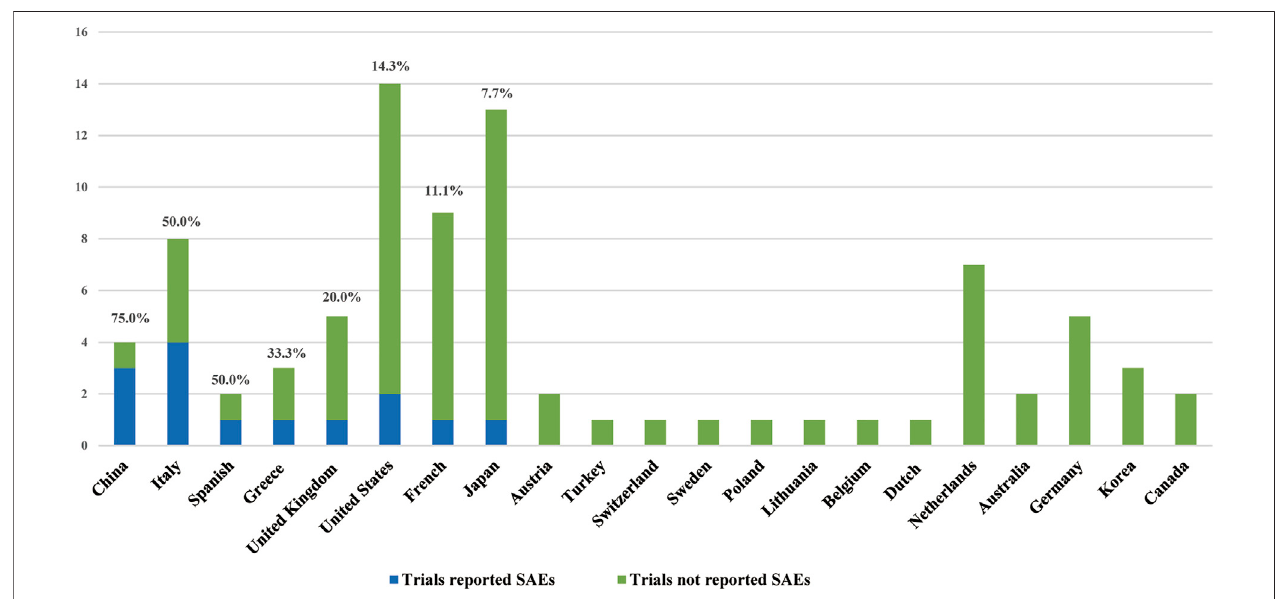
FIGURE 5 | Countries and SAEs reported